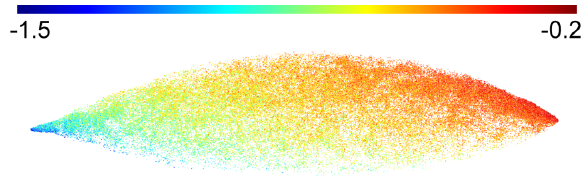
FIG. 3. 2D SHEAP map produced from 50 000 unrelaxed, randomly sampled structures on the LJ 13 PES, described by sorted lists of all pairwise distances. The projection uses a perplexity of 30, with a minimum sphere radius R 0 ¼ 0 . 01 . The circles representing each structure are colored according to energy per atom in Lennard-Jones units; see the color bar at the top of the